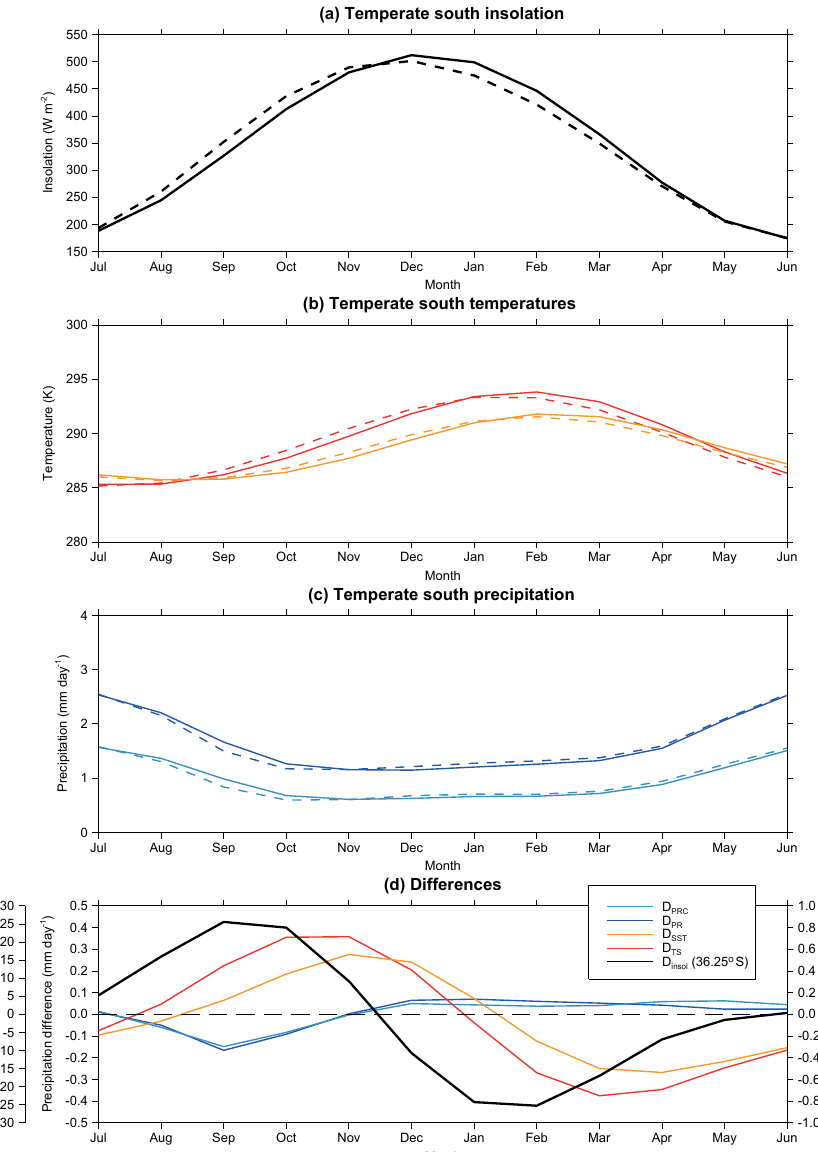
Figure 11. The monthly, ensemble and regional mean (a) insolation (taken at 36.25 ◦ S for insolation, black line, Wm − 2 ), (b) surface temperature (land and ocean combined, red line, K) and sea surface temperature (when available, amber line, K) and, (c) total precipitation (blue line, mmday − 1 ) and convective precipitation (turquoise line, mmday − 1 ) at 0ka (solid lines) and 6ka (dashed lines) within the TeS box. The difference in those fields (insolation, temperature and precipitation) for 6 − 0ka is plotted in (d) .